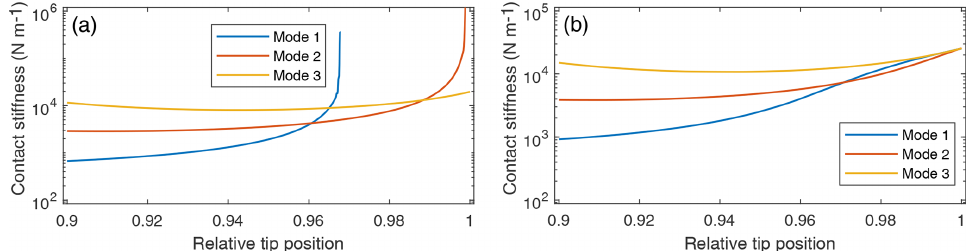
Figure 12. Calculated contact stiffness of the measured lowest three resonance peaks in dependence on the position of the tip for finding its most consistent value with (a) the length of the cantilever set to the specified value of L = 5mm (Table 1), whereby lateral forces are neglected. Here, the optimum tip position is L 1 /L = 0 . 964. (b) If the lengths of the cantilever and lateral elements are set to L = 5 . 555mm /k ∗ = γ ∗ /γ ∗ = 0 . 444, respectively, intersecting curves for all three modes are found at an optimum tip position of L 1 /L = 0 . 999. and k ∗ Lat Lat